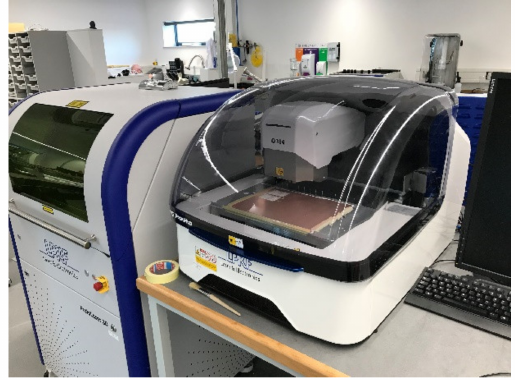
Figure 3. LPKF Protomat D104 machine used to fabricate the microstrip antenna on FR4 PCB board.